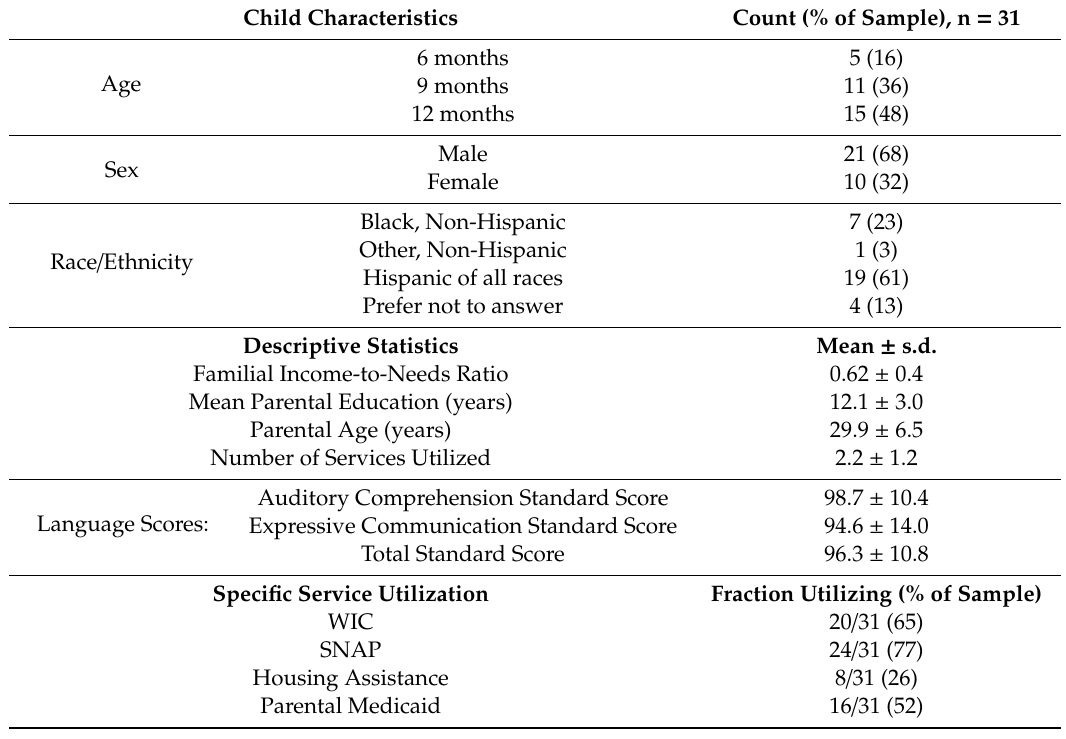
Table 1. Child and parent characteristics and use of social